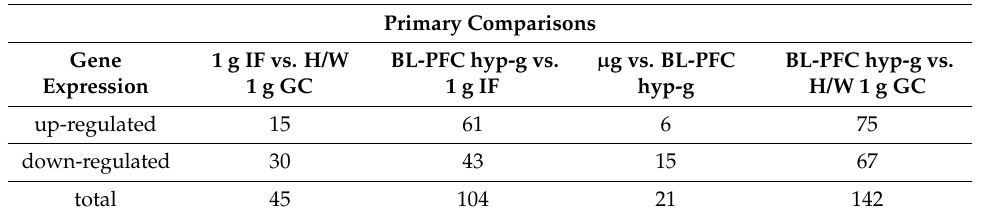
Table 7. Numbers of differentially expressed probe sets in response to altered gravitational conditions in human U937 cells during parabolic flight. Direct comparisons between the sample groups are shown.